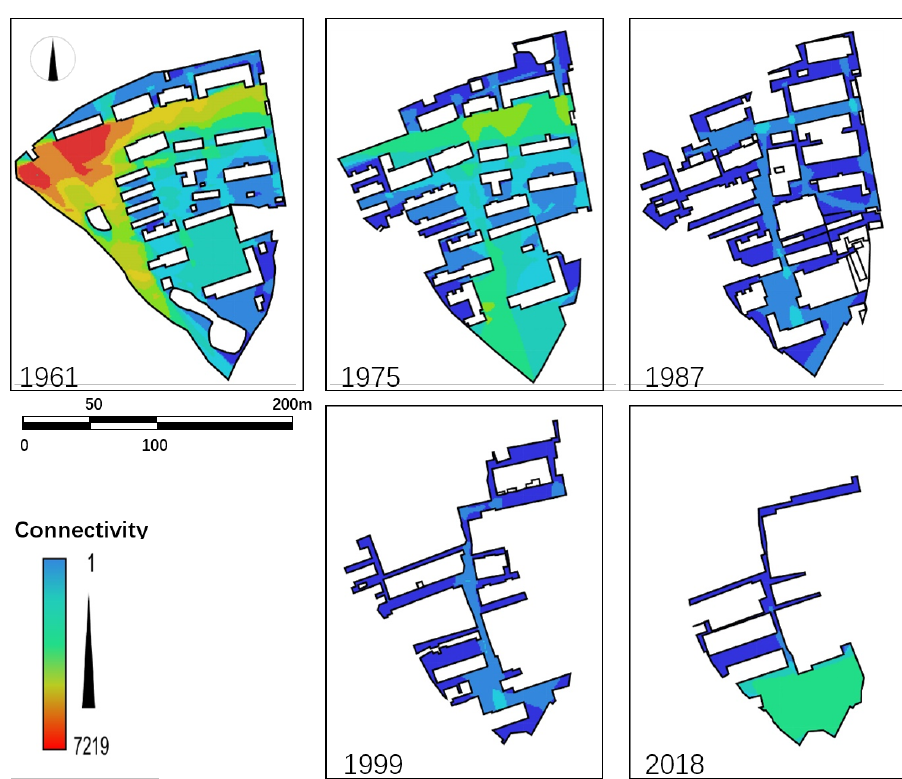
Figure 9. Connectivity of the AMS compound